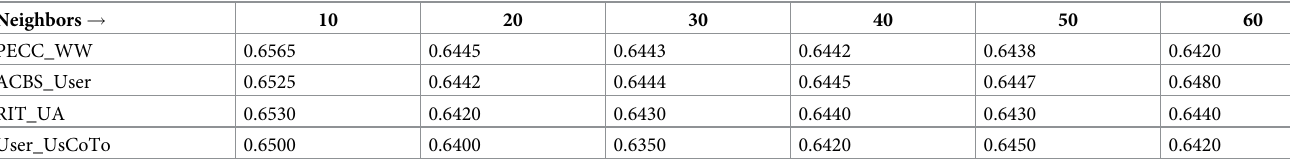
Table 6. MAE values comparison of the different models against the proposed.